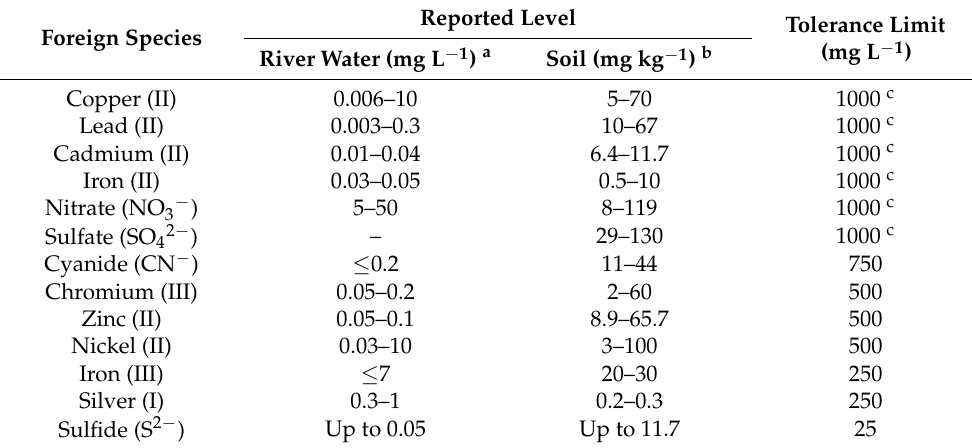
Figure 5. Calibration line using the membraneless gas-separation µ PAD for the determination of mercury and the corresponding image of the purple iodine-starch complex. Table 2. The tolerance limit of the µ PAD for analysis of Hg(II) and comparison with the reported levels of foreign species in some samples (drinking water, river water and